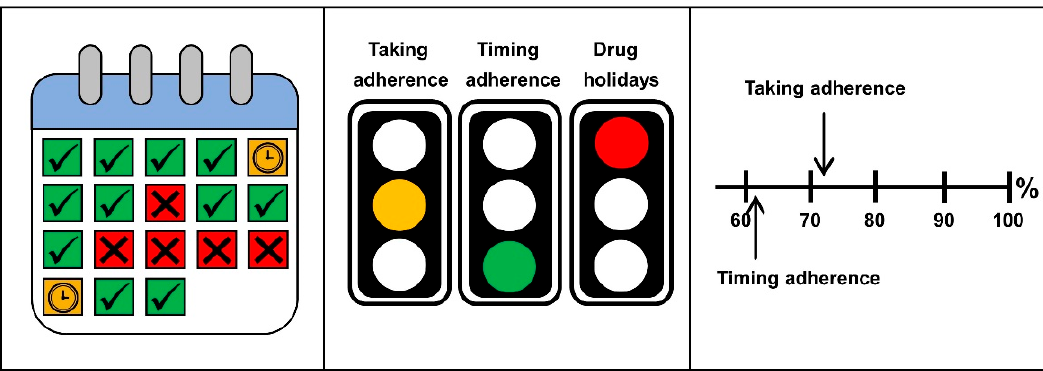
Figure 1. Graphical representations of medication adherence estimates in form of a calendar ( left ), traffic lights ( middle ), and numerical scale ( right ). The representations describe the intake of rivaroxaban once daily for the duration of 18 days, with the following estimates: taking adherence: 72%, timing adherence: 61%, drug holiday: 4 days.